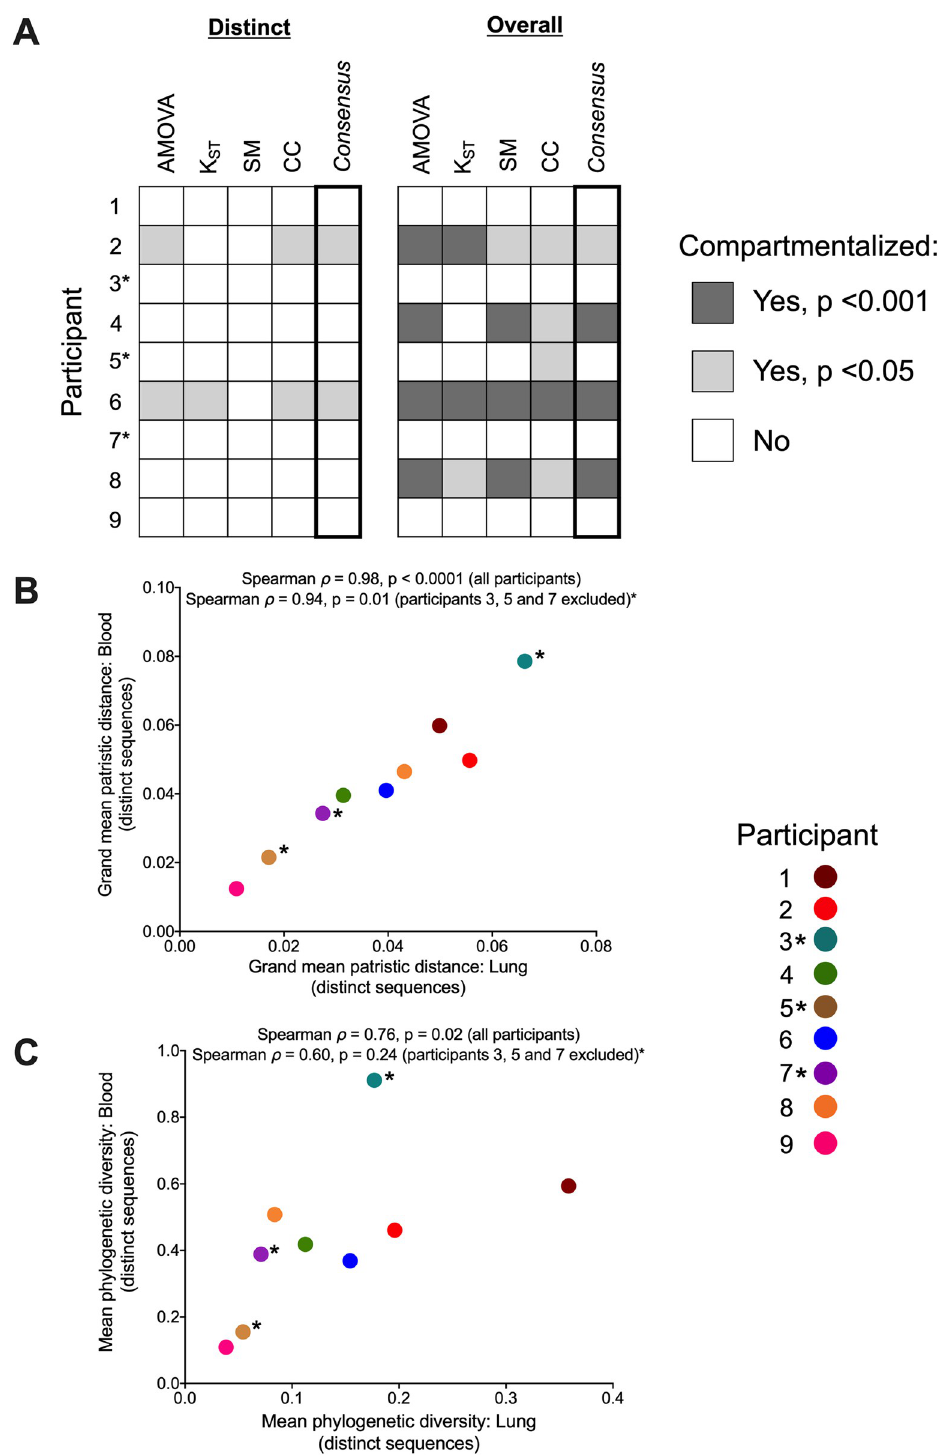
Fig 5. Summary of genetic compartmentalization results and blood-lung proviral diversity. (A) Summary of genetic compartmentalization results for the four tests used, along with the "consensus" result, where a dataset is declared compartmentalized if at least one test per type (genetic distance vs. tree-based) gave a statistically significant result. Dark grey squares denote compartmentalization with p < 0.001, light grey squares denote compartmentalization with p < 0.05; white squares denote no compartmentalization. The "Distinct" panel summarizes compartmentalization